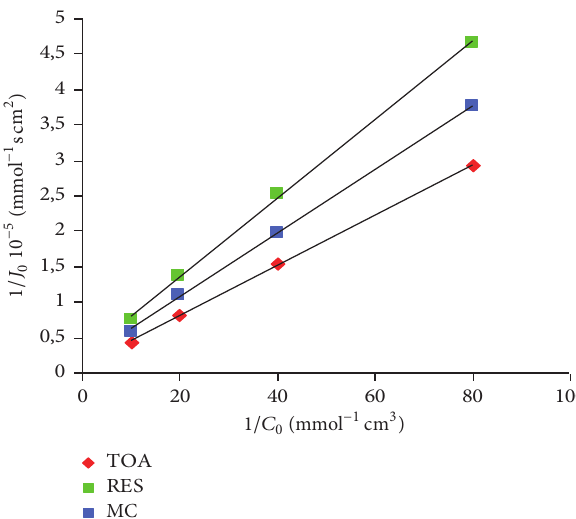
Figure 8: The Lineweaver-Burk representation 1/𝐽 0 = 𝑓(1/𝐶 0 ) for facilitated extraction of VO 2+ ions by adopted SLMs. [RESO] = [MC] = [TOA] = 10 −2 M, [H 3 O + ] = 1 M, and T = 293 K.